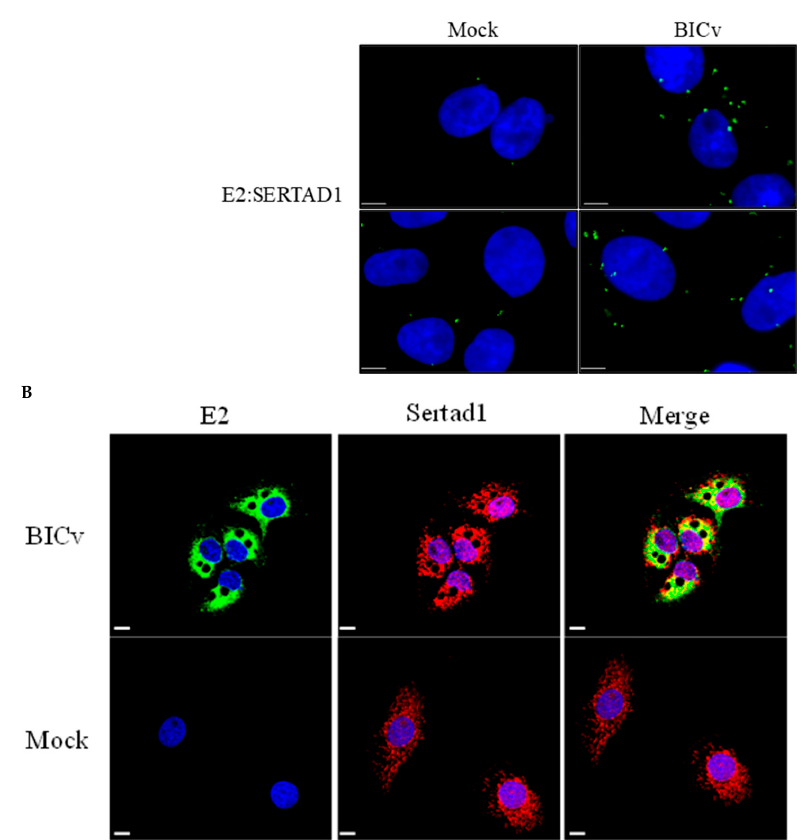
Figure 1. The interaction between classical swine fever virus (CSFV) E2 and SERTAD1 in CSFV-infected SK6 cells demonstrated by ( A ) the proximity ligation assay (PLA) (the top and bottom panels are images showing different fields within the same treatment) and ( B ) confocal microscopy in SK6 cells that were either mock-infected or infected for 24 h with CSFV BICv. The size bars are 10 µm. Viruses 2020 , 12 , x FOR PEER REVIEW